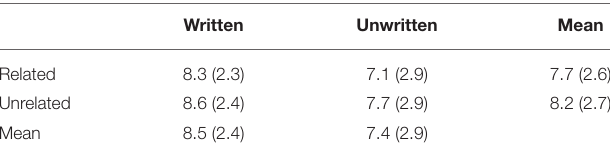
TABLE 1A | Mean score out of 10 (standard deviations) for the extent to which the description indicates a unique language, comparing the presence of a writing system and relatedness to another language.